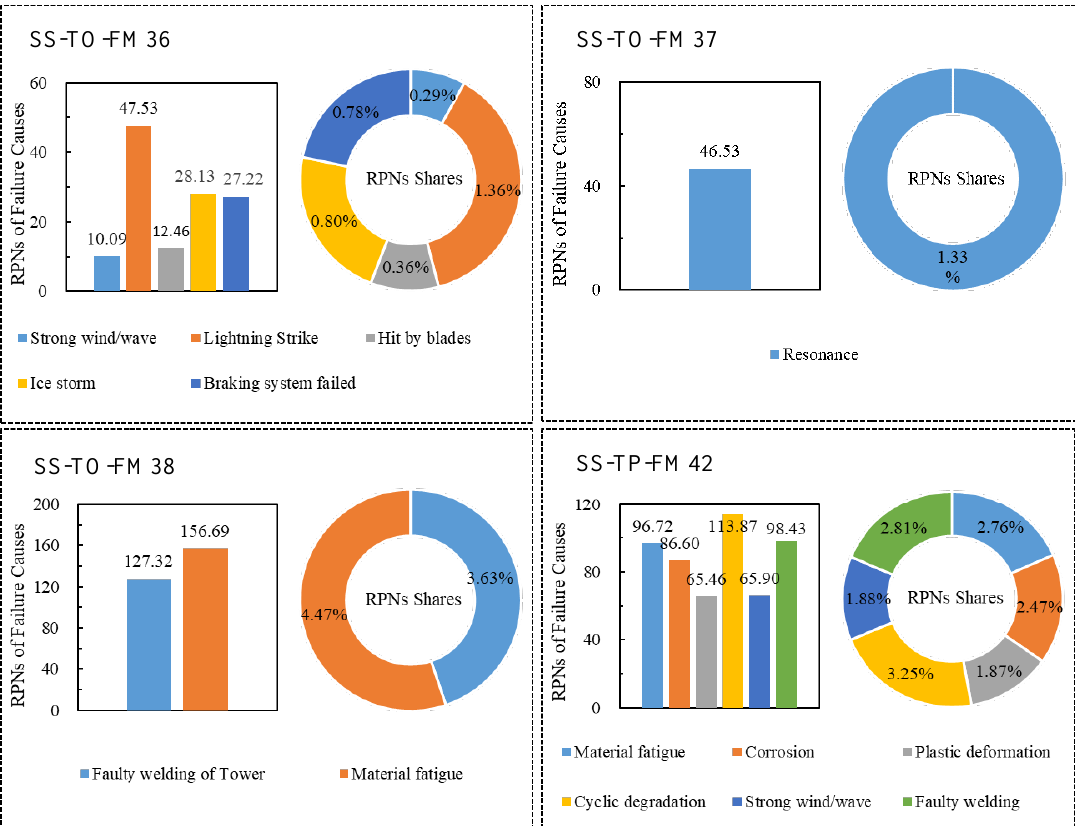
Figure 6. Failure features of the tower and the transition piece/SS-TO-FM36: Tower collapse; SS-TO- FM37: Tower abnormal vibration; SS-MS-FM38: Tower crack; SS-TP-FM42: Transition piece crack.